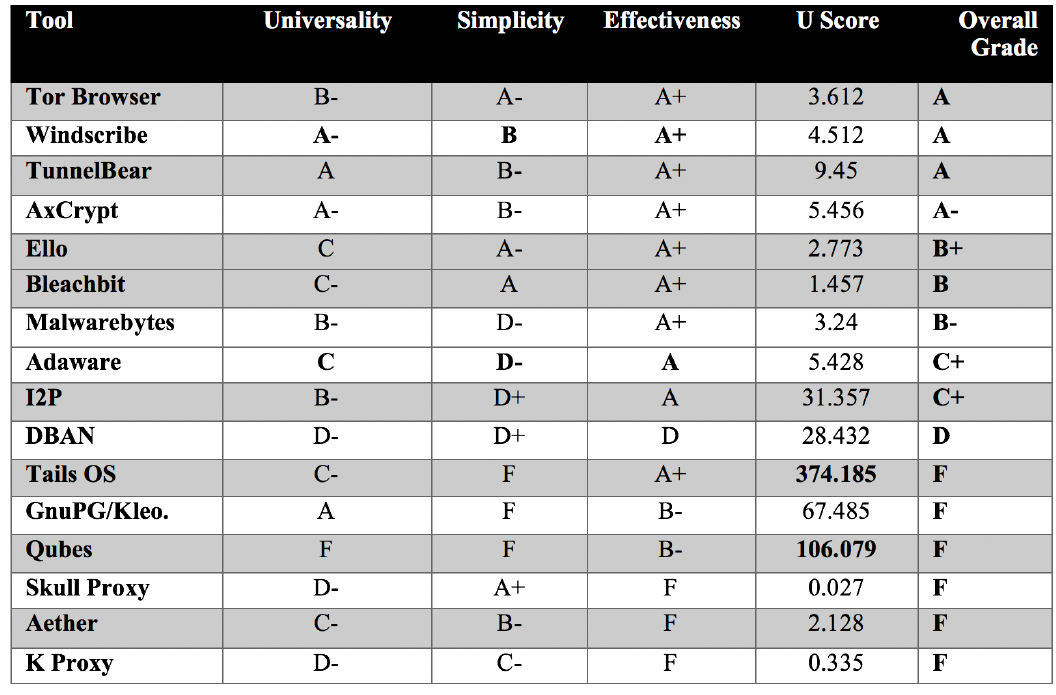
Figure 4. Table of